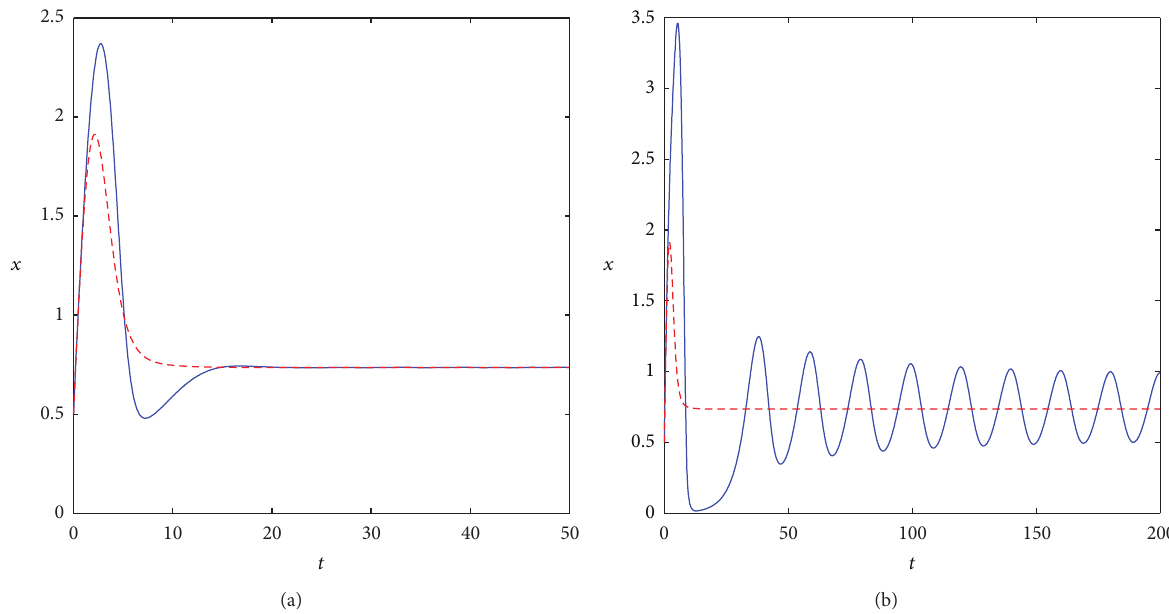
Figure 2: The solution for nutrients where 𝐼 = 1 . 3: (a) 𝜏 = 0 (red dashed line), 𝜏 = 1 (blue solid line); (b) 𝜏 = 0 (red dashed line), 𝜏 = 4 (blue solid